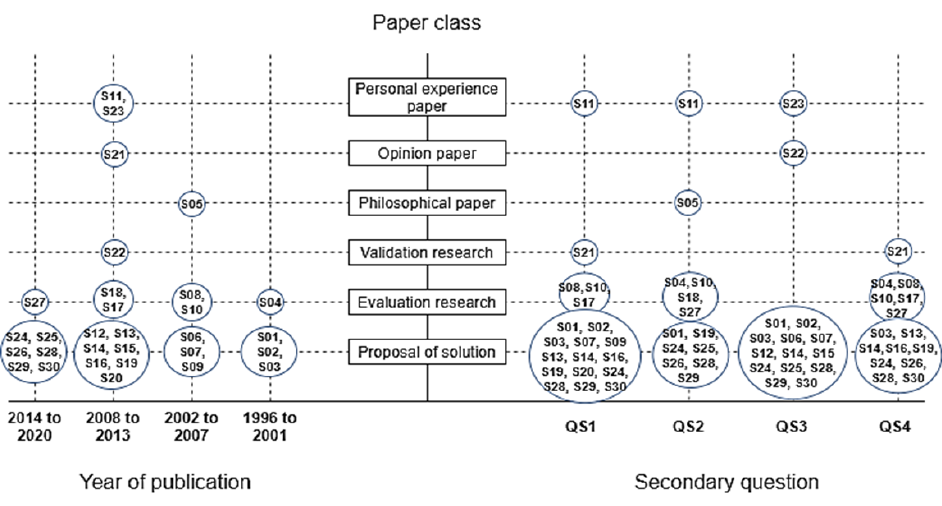
Figure 4. Research